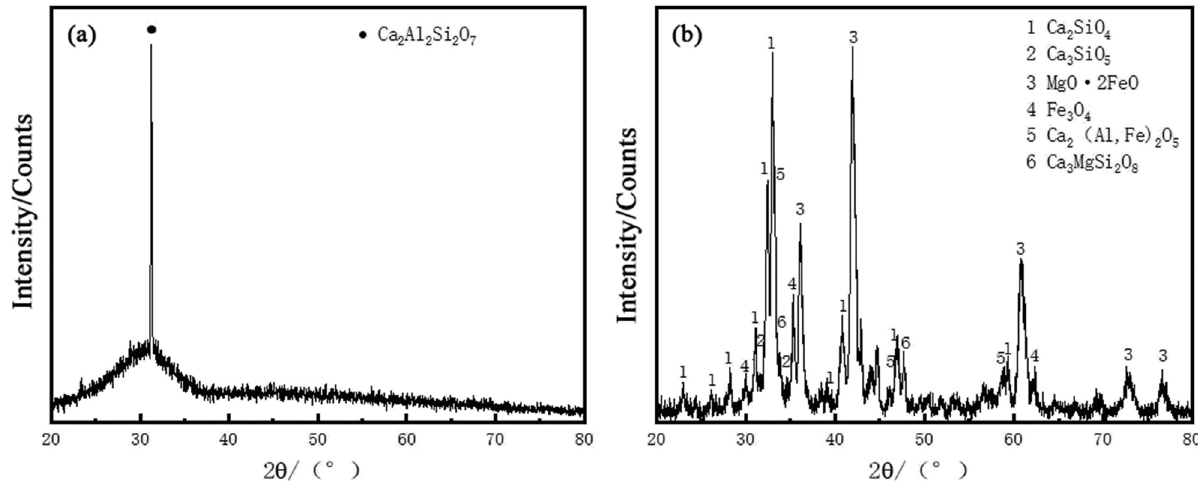
Figure 1: X - ray di ff raction pattern: ( a ) Baogang high furnace slag; ( b ) Baogang steelmaking